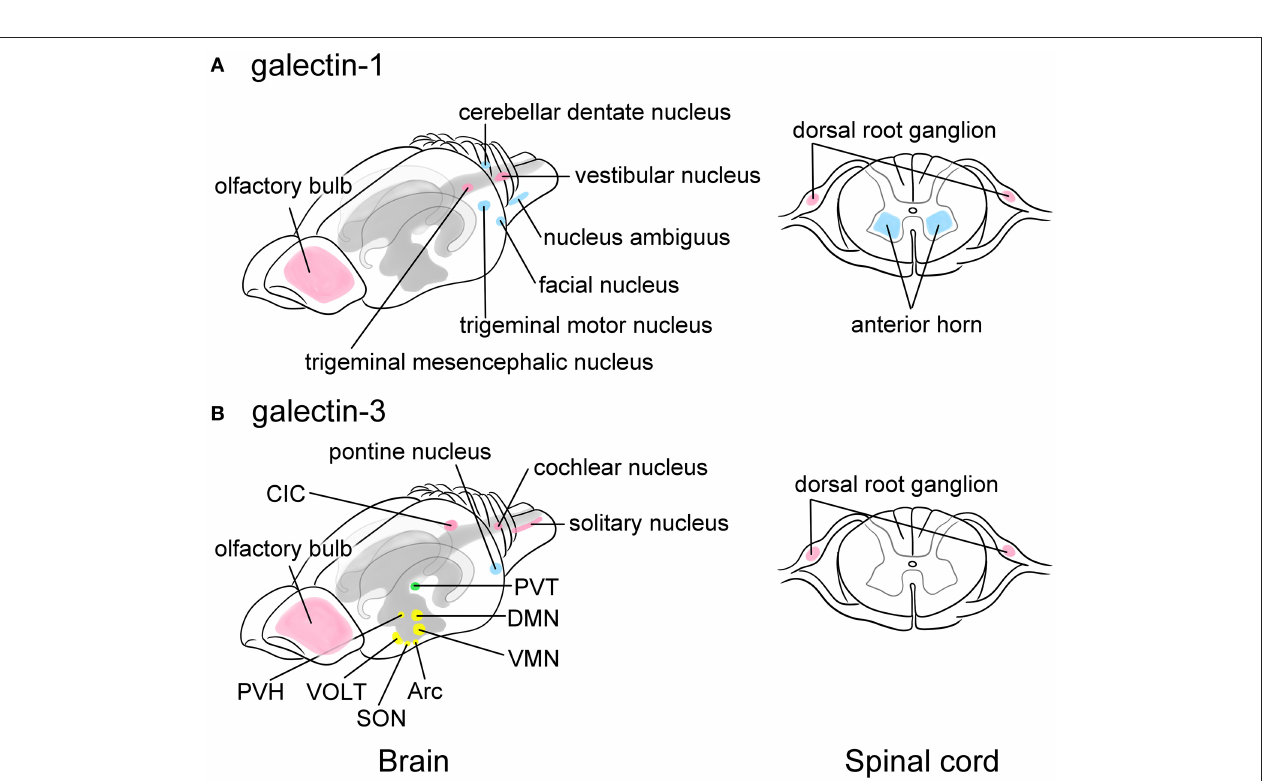
FIGURE 2 | Schematic images showing the predominant localization of galectin-1 (A) and -3 (B) in neurons of the adult rat brain (left) and the spinal cord (right). Galectin-1 is predominantly localized to motoneurons or neurons controlling voluntary movements such as the facial nucleus, the trigeminal motor nucleus, the nucleus ambiguus, and the cerebellar dentate nucleus in the brain stem as well as the anterior horn of the spinal cord (blue in A ). Certain sensory neurons, including the trigeminal mesencephalic nucleus and the vestibular nucleus in the brain and the neurons in the dorsal root ganglion (DRG) also contain galectin-1 (pink in A ). Galectin-3 is abundant in the arcuate nucleus (Arc) and the dorsomedial nucleus (DMN), and moderately expressed in the ventromedial nucleus (VMN), the supraoptic nucleus (SON), and the paraventricular nucleus (PVH) in the hypothalamus that play central role in the regulation of appetite control, endocrine/autonomic system, and stress response (yellow in B ). Galectin-3 is also present in the vascular organ of the lamina terminalis (VOLT), one of the sensory circumventricular organs (yellow in B ). The paraventricular nucleus in the thalamus (PVT) related to the emotion also highly expresses galectin-3 (green in B ). Other nuclei such as the central nucleus of inferior colliculus (CIC), the cochlear nucleus, and the solitary nucleus also express galectin-3 (pink in B ), suggesting its role in the regulation of taste and hearing sensing. Similar to galectin-1, the primary sensory neurons in the DRG express galectin-3 (pink in B ). The pontine nucleus regulating voluntary movements also contains abundant galectin-3 (blue in B ). Olfactory bulb expresses both galectins (pink in A and B ). Motoneurons and neurons involved in movement are represented in blue, sensory-related neurons are in pink, and the neurons regulating endocrine/autonomic functions are indicated in yellow, and nucleus related to higher brain function is labeled in green. The cerebral ventricles are indicated in gray and the hippocampus is bordered in light gray. This figure is created based on the in situ hybridization data by Hynes et al. (1990) for galectin-1 and immunohistochemical data by Yoo et al. (2017) for galectin-3. For detailed localization of galectins in the rat brain, please refer their manuscripts. For data of the mouse and human brain, please visit Allen Brain Map (https://portal.brain-map.org).